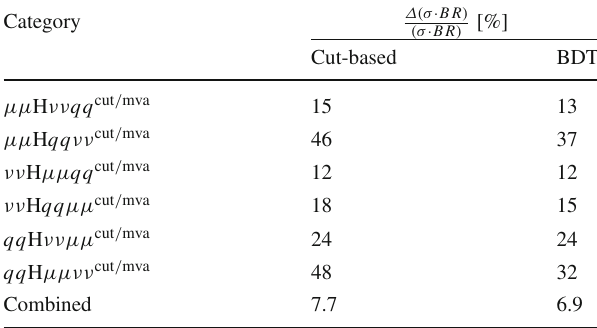
Table 4 Statistical uncertainties on the product of the ZH cross section and the branching ratio. The bottom row shows the result of combined value of the six